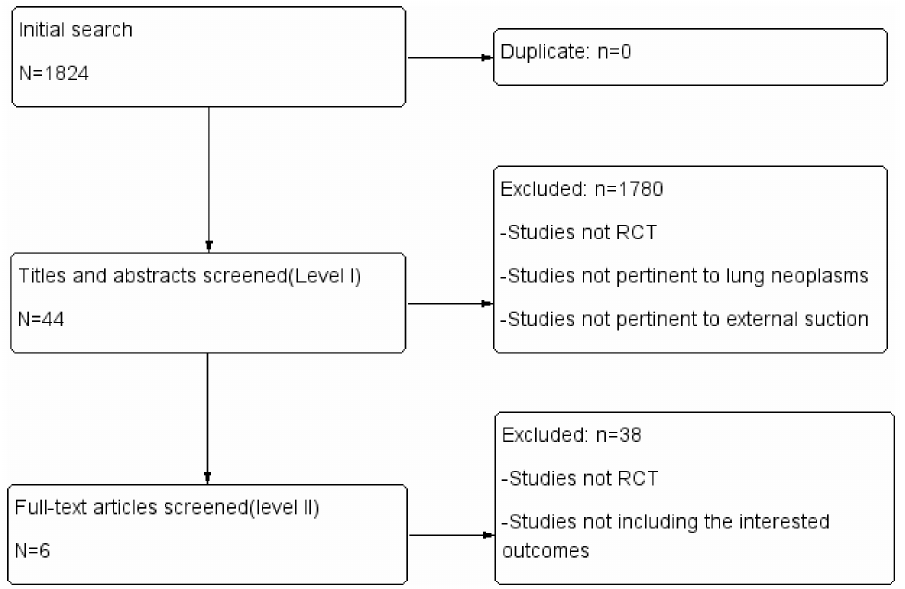
Figure 1. Flow chart of the literature screening.